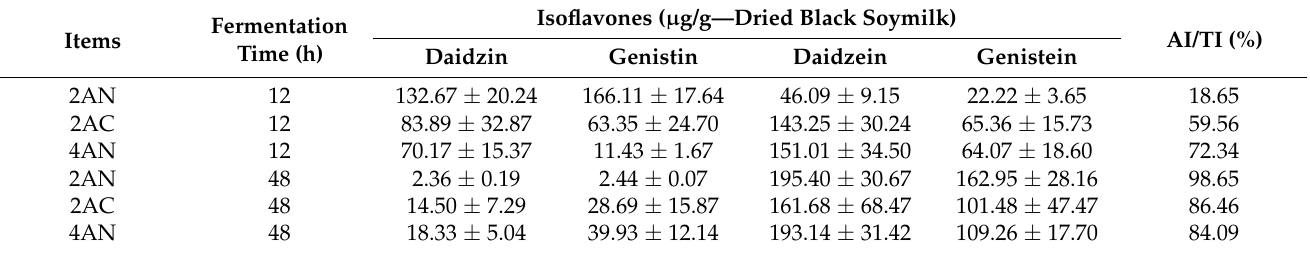
Table 2. Effect of encapsulation modes of encapsulated L. plantarum BCRC 10357 on the biotransfor- mation of isoflavones in black soymilk at 37 ◦ C